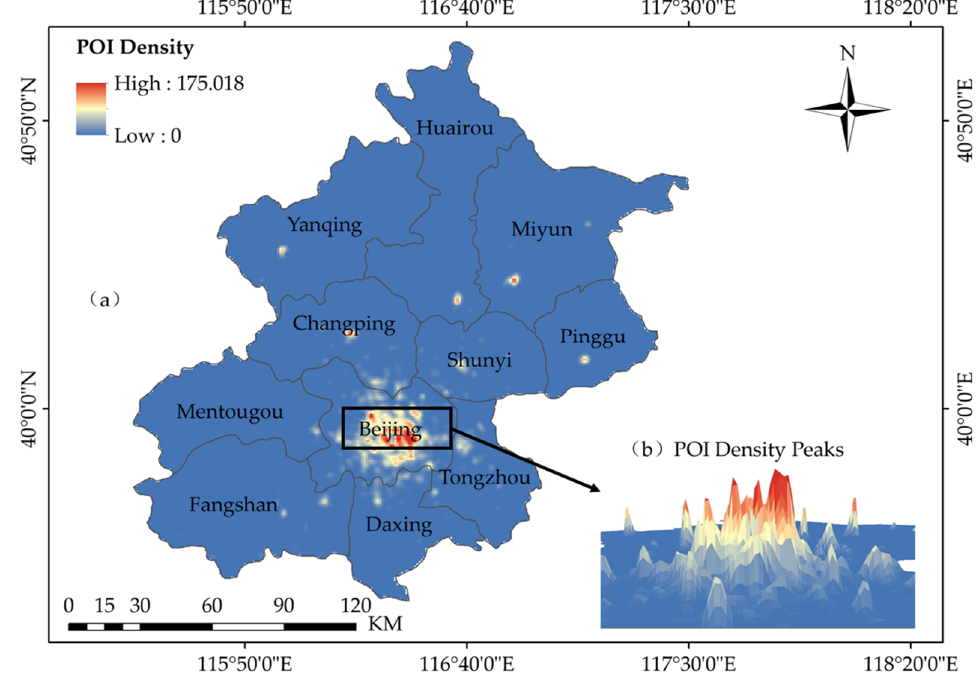
Figure 3. Kernel density map of the first principal component image.